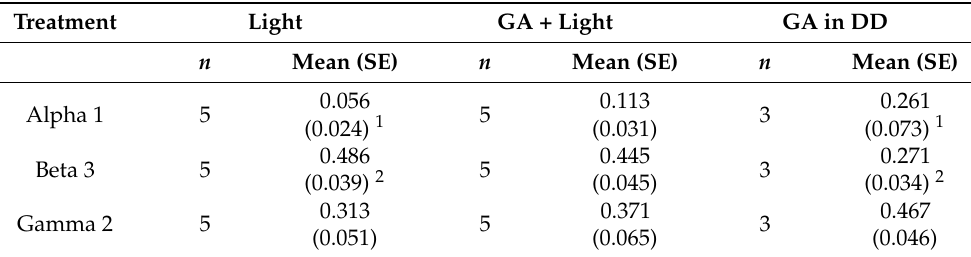
Table 4. Summary statistics of GABA A R subunit expression during early circadian times at which phase shifts due to light and GA are negligible (CT3–CT7). Evidence of differences between treatment groups was tested by ANOVA. Different treatments that share the same superscript number indicate the difference between them is statistically significant (Tukey’s HSD p < 0.05). Treatment Light GA + Light GA in DD n Mean